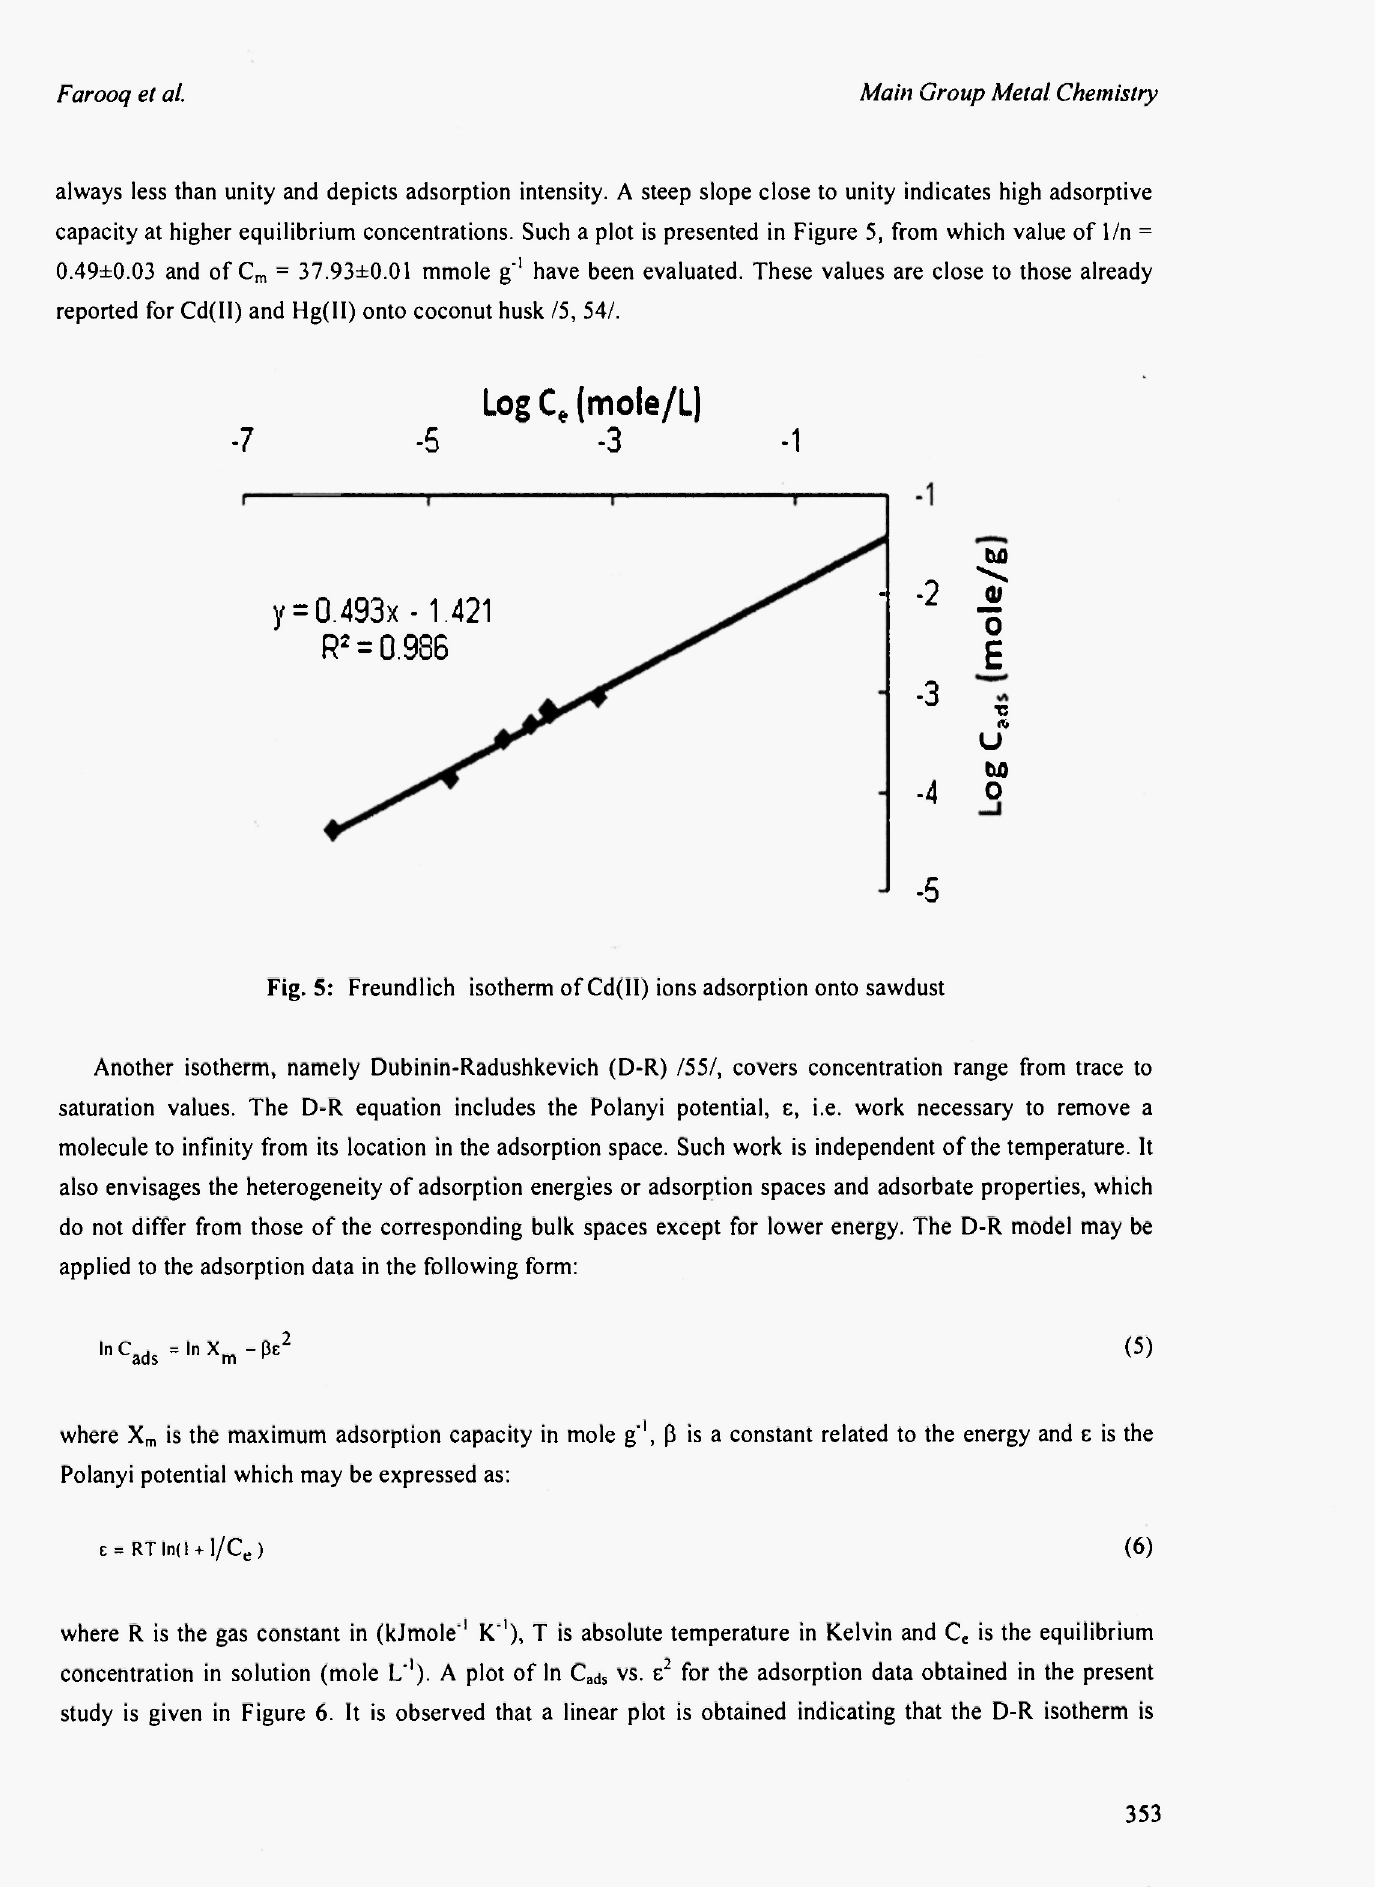
Fig. 5: Freundlich isotherm of Cd (II) ions adsorption onto